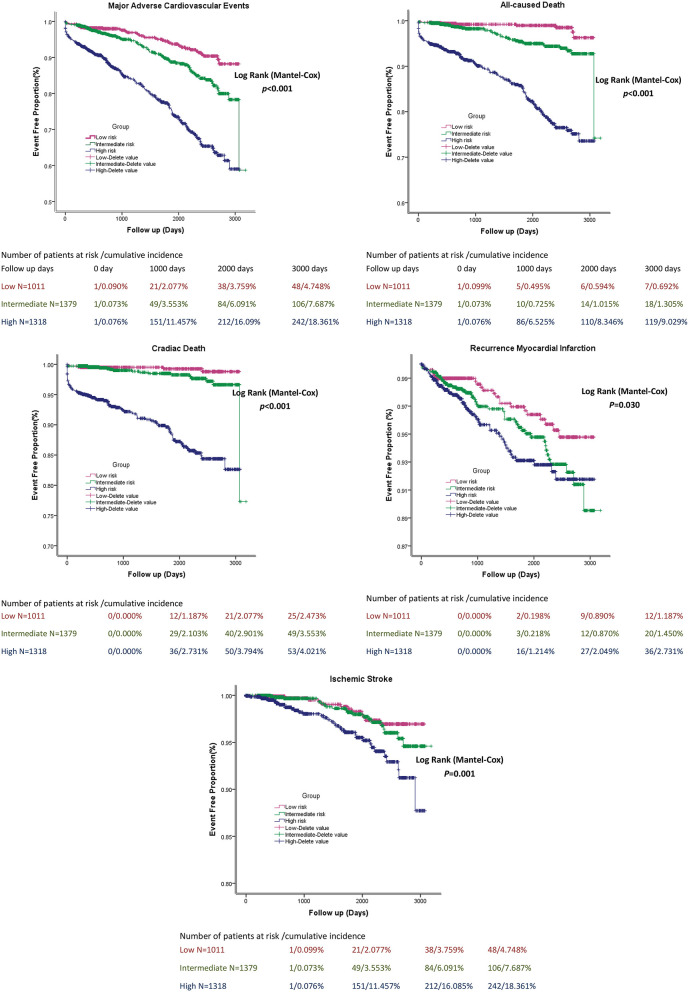
The cumulative survival rate of patients in stratified Bilirubin based-score model groups.